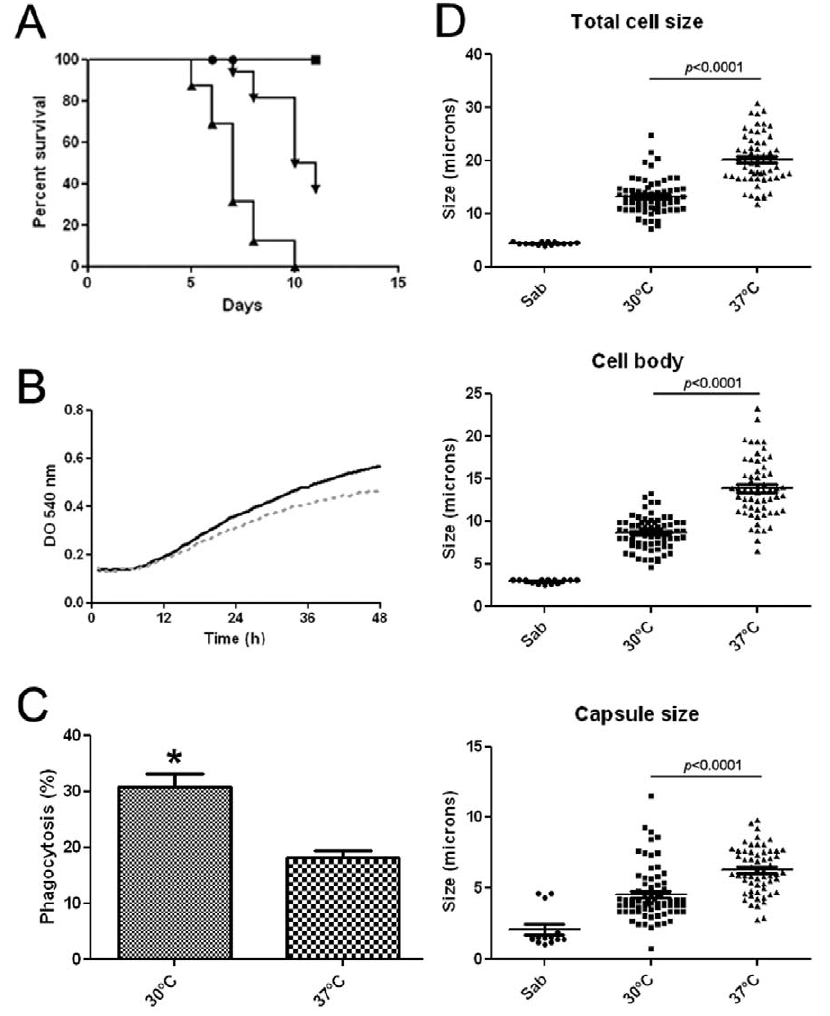
Figure 4. Temperature dependent virulence and morphogenesis of C.neoformans in G.mellonella . A ) Survival curves of G. mellonella N infected with 10 4 H99 cells. Sixteen larvae per group were incubated at 30 u C ( . ) and 37 u C ( m ). A group of larvae were injected with PBS and kept at ) and at 37 u C ( & ) to control the trauma of the injection. B ) Growth curves of H99 strain at 30 u C (Black line) and at 37 u C (grey dotted line) 30 u C ( during 48 h. C ) In vivo phagocytosis was performed as described in Material and Methods and quantified after 2 h of incubation of the larvae at 30 u C and 37 u C. P , 0.05 is indicated with an asterisk. D ) Distribution of total cell size, cell body size and capsule diameter of C. neoformans cells grown in Sabouraud (Sab) and recovered from G. mellonella caterpillars at different temperatures after 6 d of infection. T-test and scatter plot graphs were performed using Graph Pad Prism 5. The line in each sample denotes the average of the distribution.